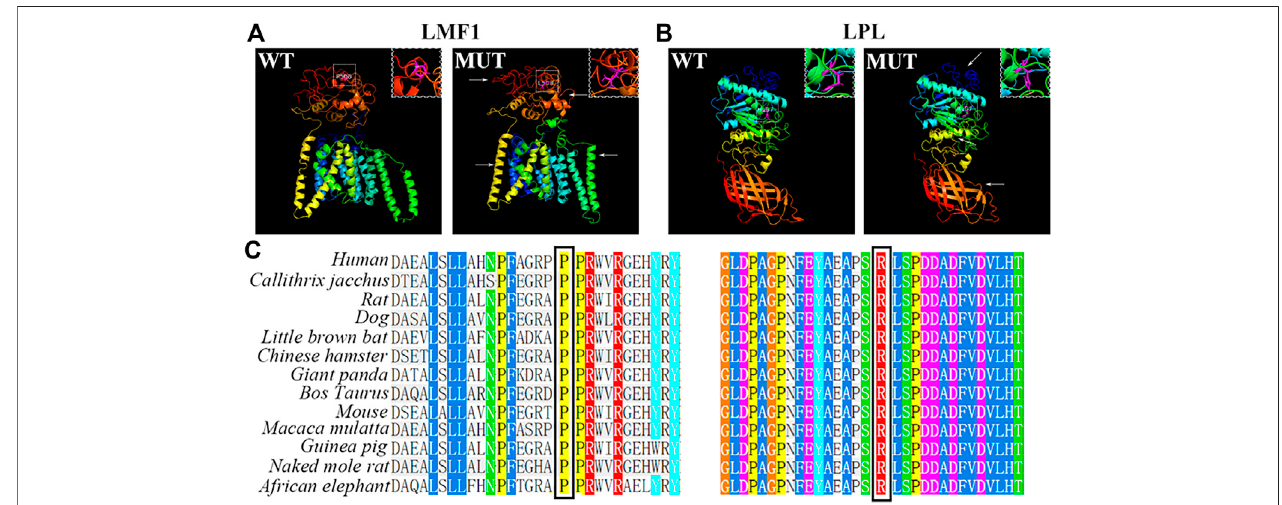
FIGURE 2 | Bioinformatics analysis of the mutation. (A) . Prediction of wild-type (left) and mutant (right) protein structures of LMF1 by I-TASSER. (B) . I-TASSER prediction of wild-type (left) and mutant (right) protein structures of LPL. (C) . Sequence alignment of mutant amino acids on LMF1 (P508) or LPL (R197) across different species. White box: the mutated position; Arrows: changes compared to the wild-type structure; Magenta: mutant amino acids.